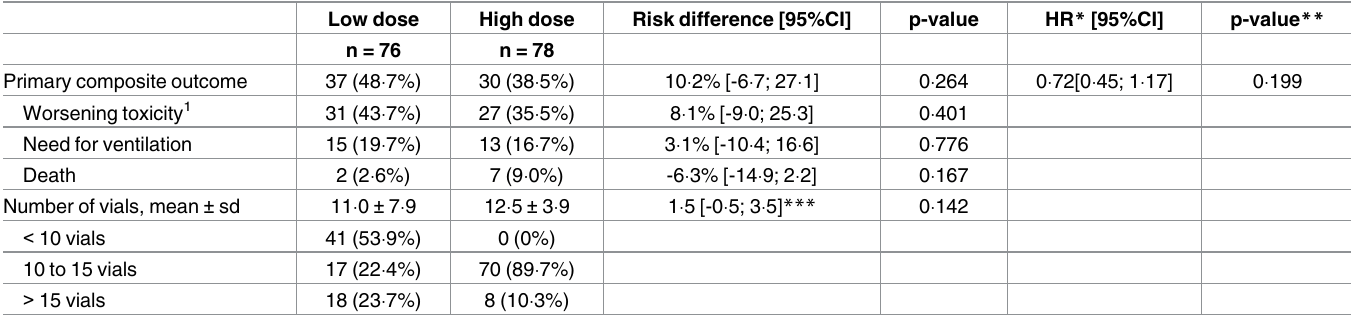
Table 2. Effectiveness endpoints in modified intention-to-treat population. Figures are numbers of participants (percentage) unless stated otherwise. Low